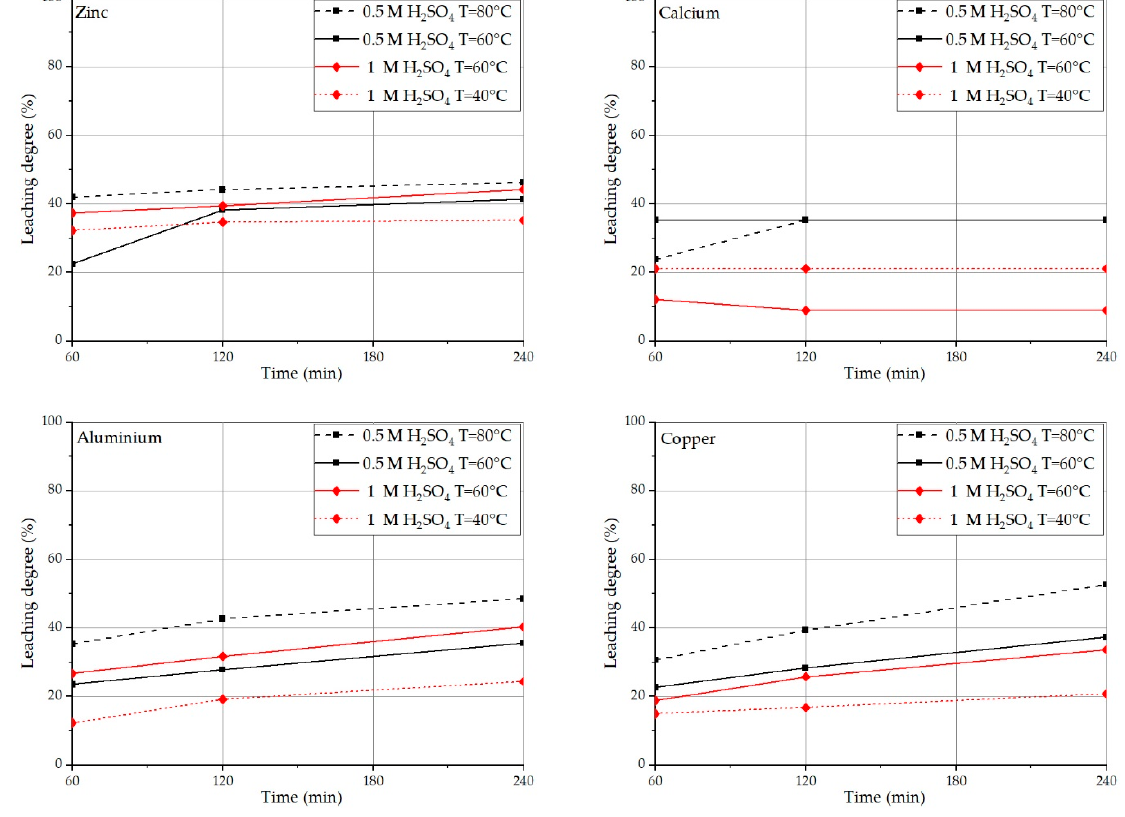
Figure 6. Influence of temperature on leaching degree, 30 g PPCB in 0.5 M and 50 g PPCB in 1 M sulfuric acid.